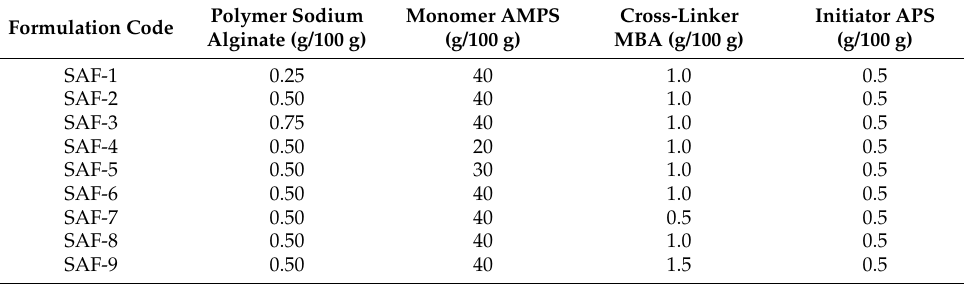
Table 4. Various compositions of SA-co-poly(AMPS) hydrogel